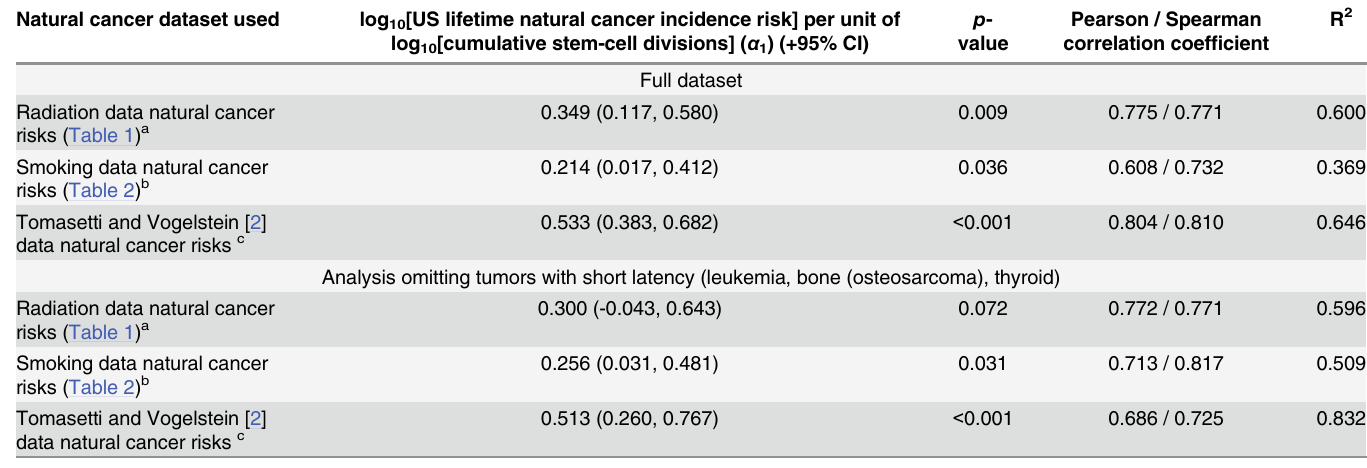
Table 6. Trends of linear regression model (13) of log 10 [US lifetime natural cancer incidence risk] vs log 10 [cumulative stem-cell divisions]among cancer sites with available radiation risk (Table 1) or smoking risk (Table 2) data, and in the dataset of Tomasetti and Vogelstein [2], and in some cases omitting tumors with short latency (leukemia, bone,